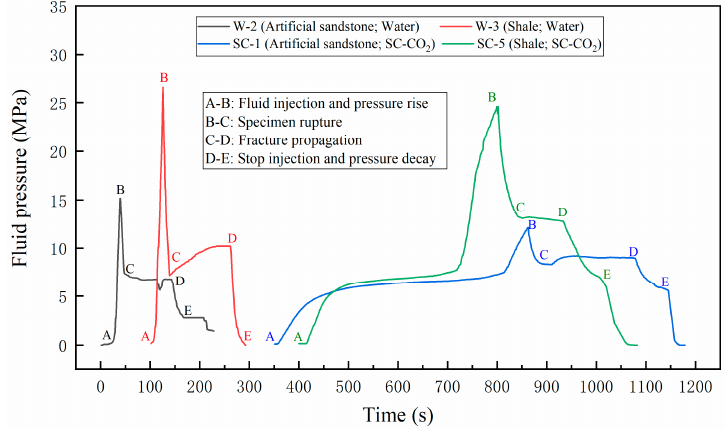
Figure 3. Fluid pressure-time curves during fracturing.